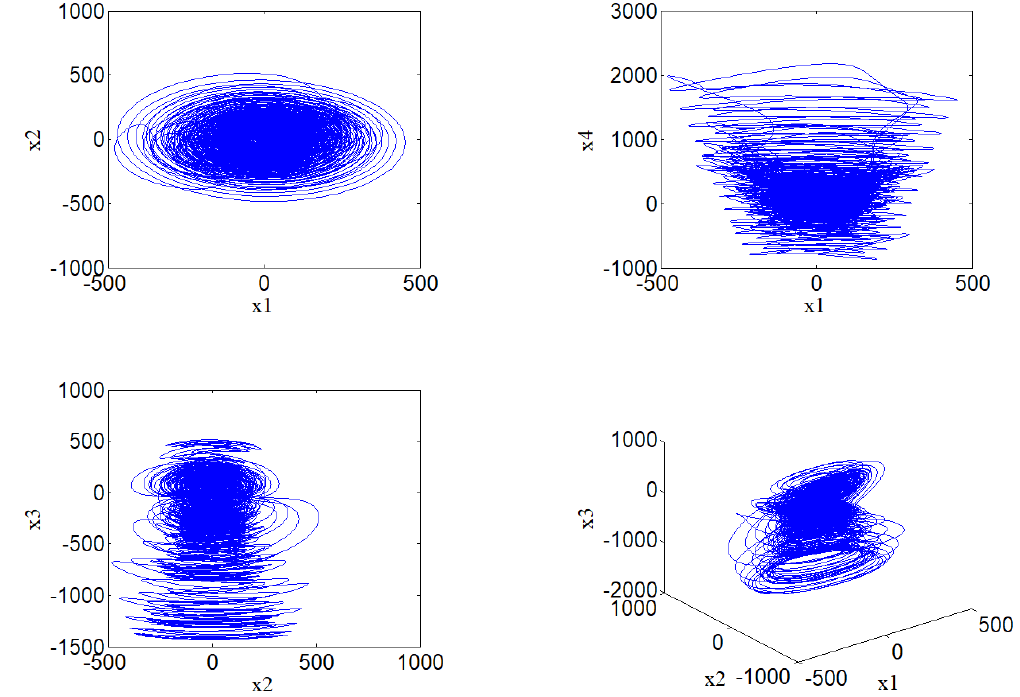
Figure 6. The hyperchaotic system phase space diagrams with parameters a = 50, b = 26, c = 13, d = 8, e = 33 and f = 30.